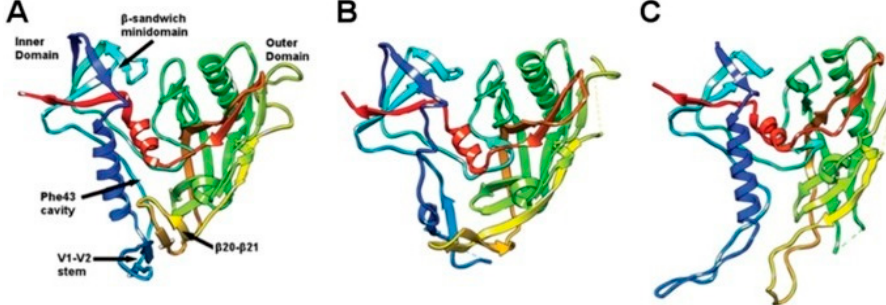
Figure 5 . Structure of gp120 in different ligation states. ( A – C ) Comparisons of gp120 structures in ( A ) the CD4-bound state; ( B ) the b12 antibody-bound state; and ( C ) the F105 antibody-bound state. Structures are rendered as ribbon diagrams colored spectrally along the sequence from blue at the N-termini to red at the C-termini. The view is into the face occupied by CD4 interactions. (Figure from Korkut & Hendrickson [211].)